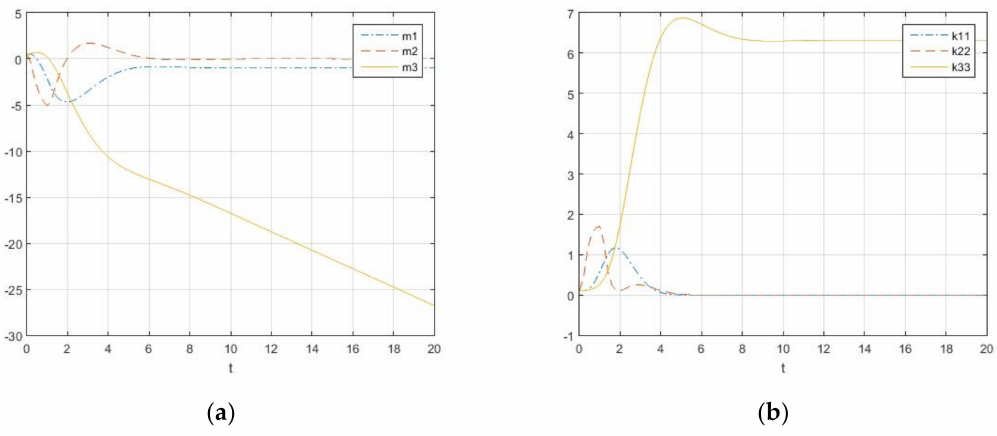
Figure 4. ( a ) Graphs m 1 , m 2 , m 3 at α = 180 ◦ , N = 1; ( b ) Graphs k 11 , k 22 , k 33 at α = 180 ◦ , N = 1.